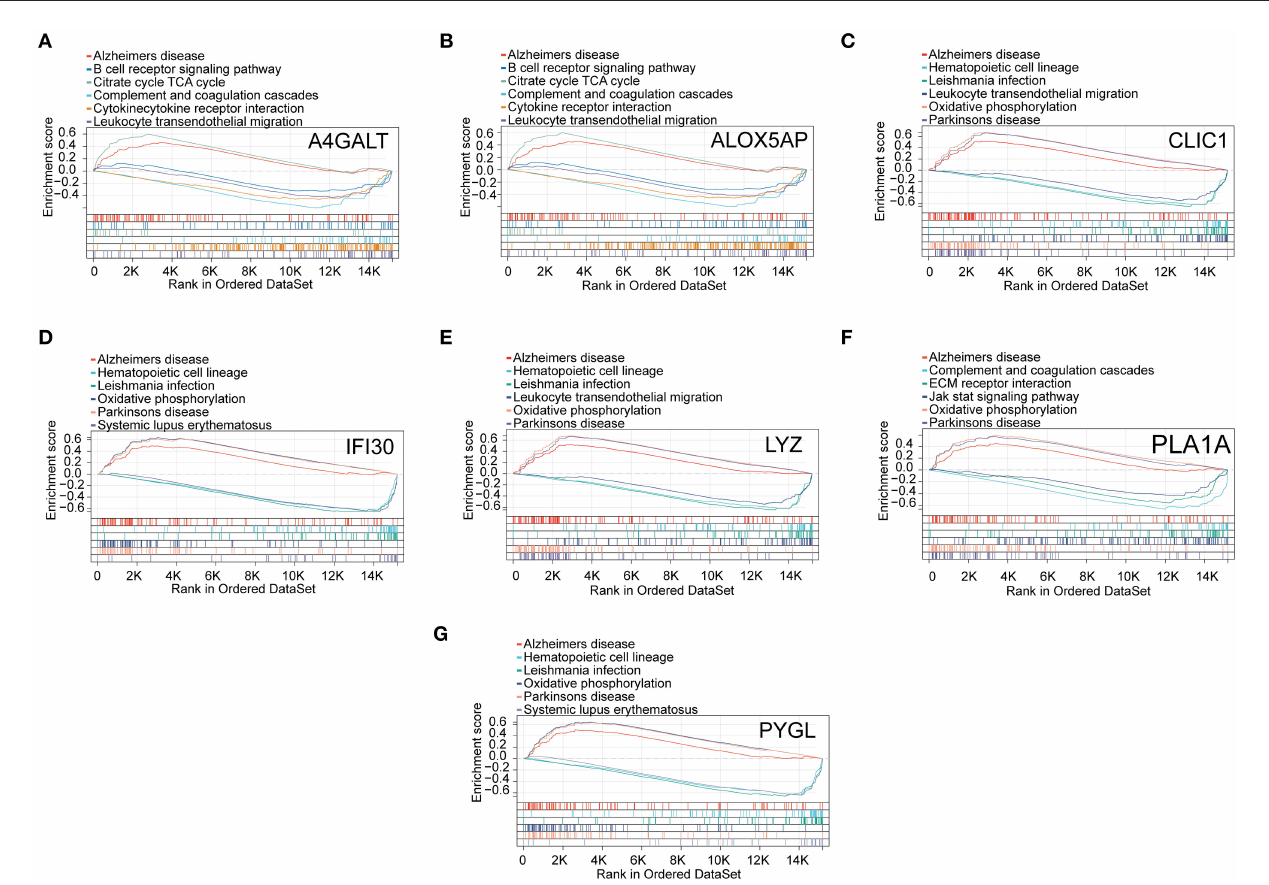
FIGURE6 GSEA revealed the enriched pathways of the hub genes. (A) A4GALT, (B) ALOX5AP, (C) CLIC1, (D) IFI30, (E) LYZ, (F) PLA1A, and (G) PYGL.